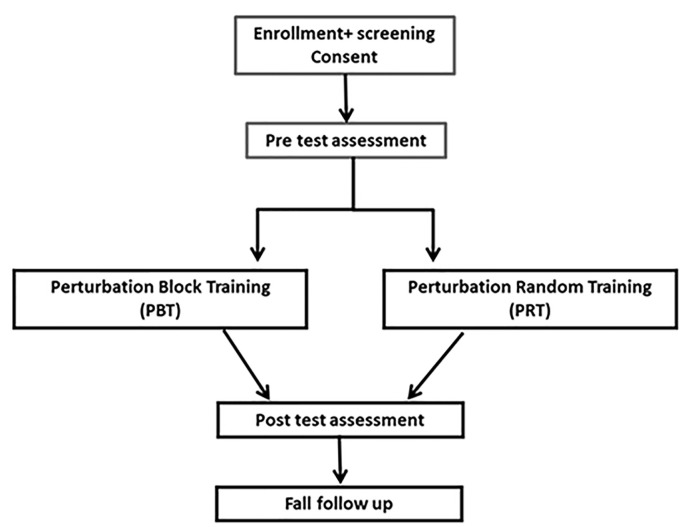
Study flowchart.